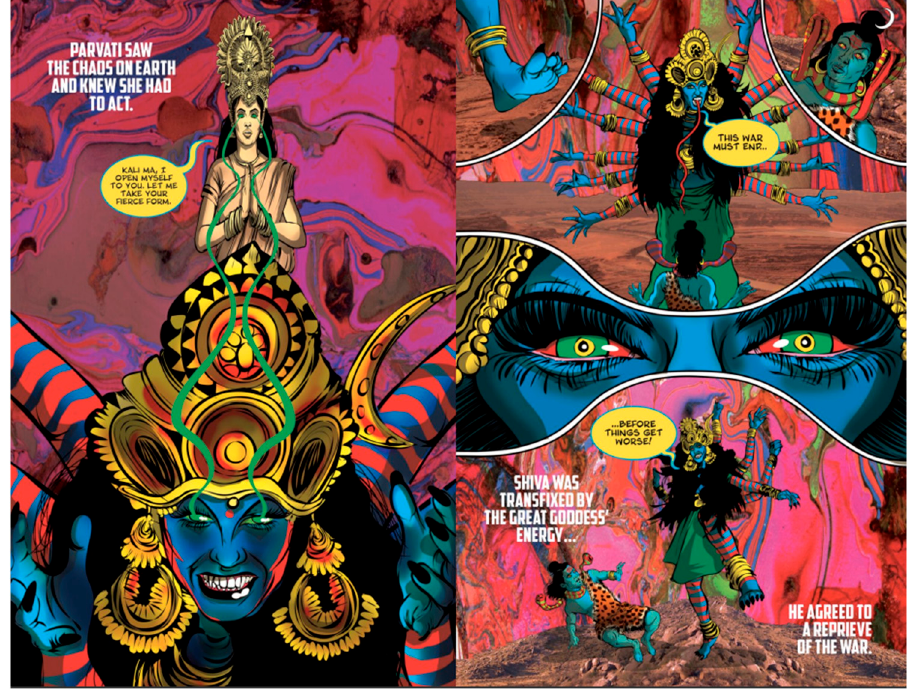
Figure 10. The goddess Kali persuades Shiva to intervene and end the war. Image Courtesy: Ram Devineni.